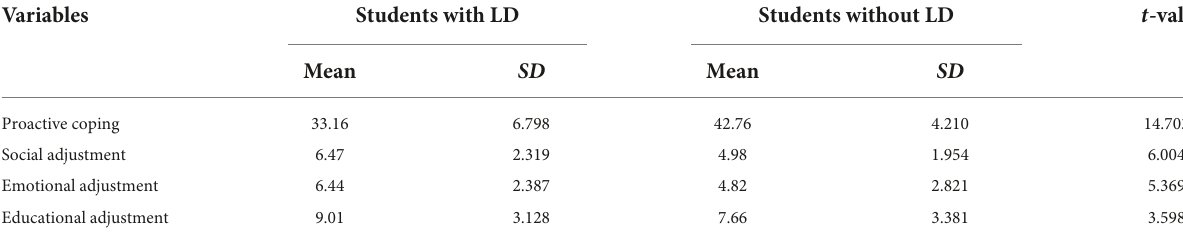
TABLE 3 ‘t’ test comparison of proactive coping and social–emotional adjustment between students with and without learning disabilities.